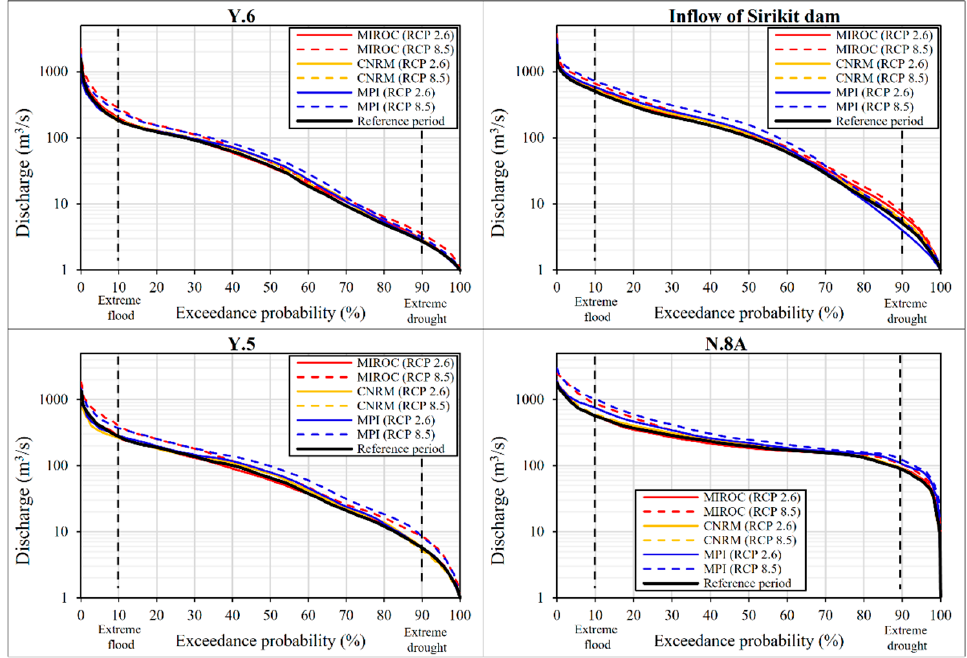
Figure 10. Flow Duration Curve during the intermediate future (2046–2070) under scenarios RCP 2.6 and RCP 8.5 compared with the reference period.